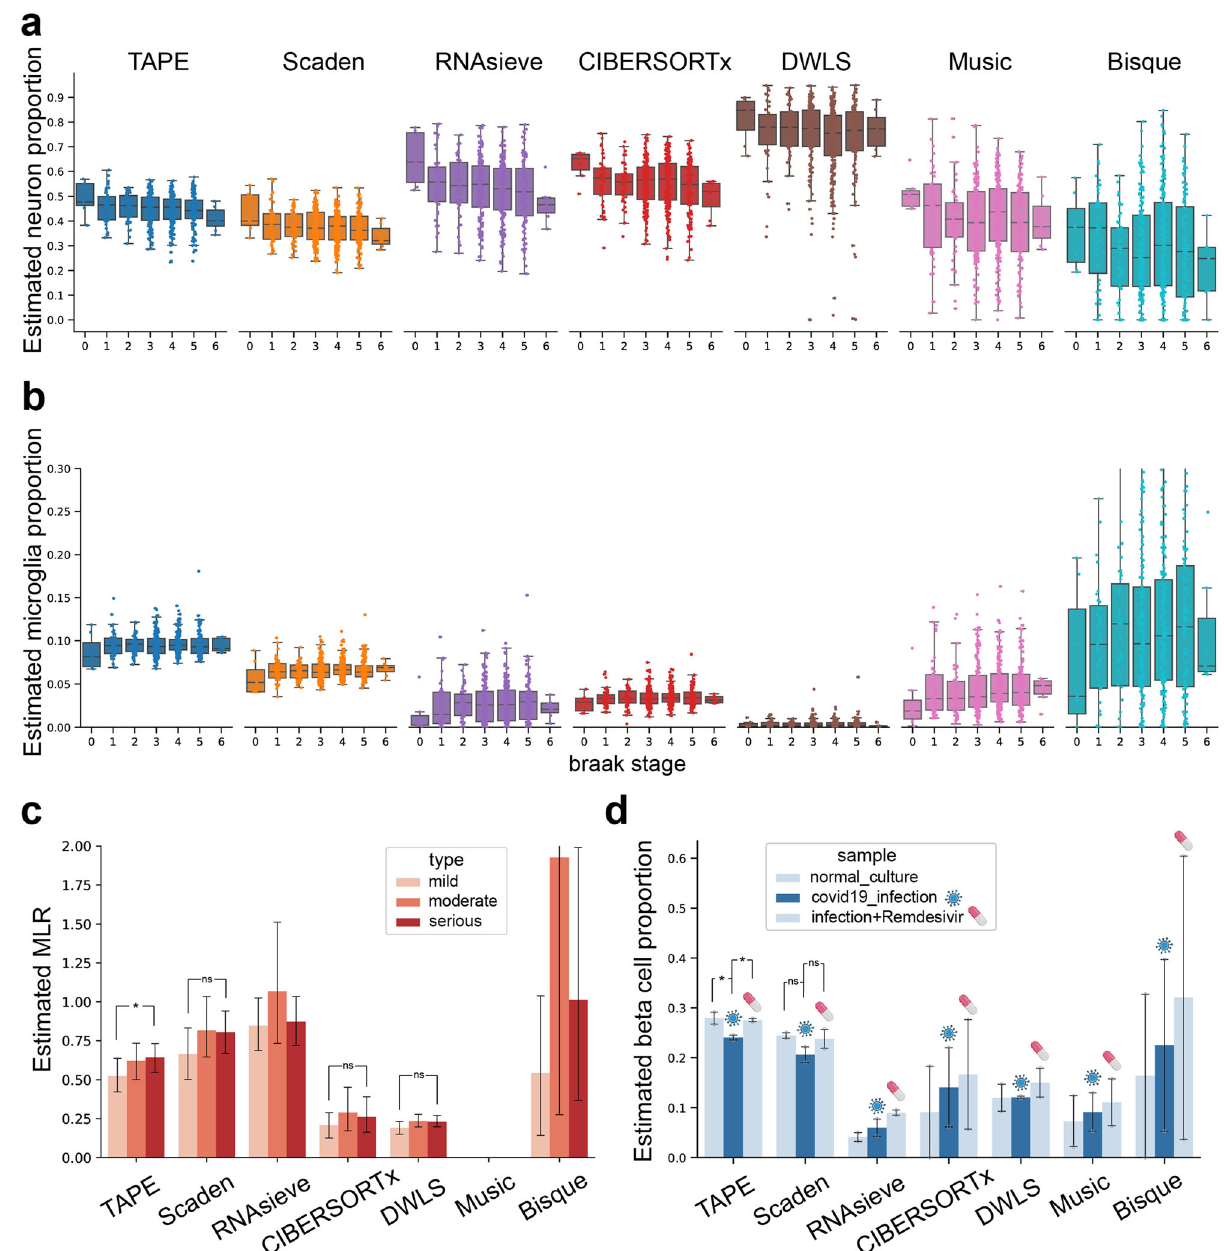
Fig. 3 | Deconvolution benchmark on datasets with clinical information. a Comparison of estimated neuron cell proportion on different Braak stages between different models on the ROSMAP dataset. Neuron content is expected to decrease along with the development of AD. b Microglia content estimated by differentmethodsonBraakstage.Thefractionisexpectedtoincreasefromstage0 to5followedbyadecreasefromstage5to6.In a , b ,samplesizeofeachstagefrom 0 to 6 is 7, 43, 47, 150, 174, 104, and 7, respectively. The boxes represent IQR while the solid line represents the median. The whiskers extend to points that lie within 1.5IQRsofthelowerandupperquartile,andthenobservationsthatfalloutsidethis range are displayed as points independently. c Estimated MLR value calculated from the estimated monocytes fraction divided by the sum of estimated propor- tions of CD4 + T cell, CD8 + T cell, and B cell. We expect MLR value increases from